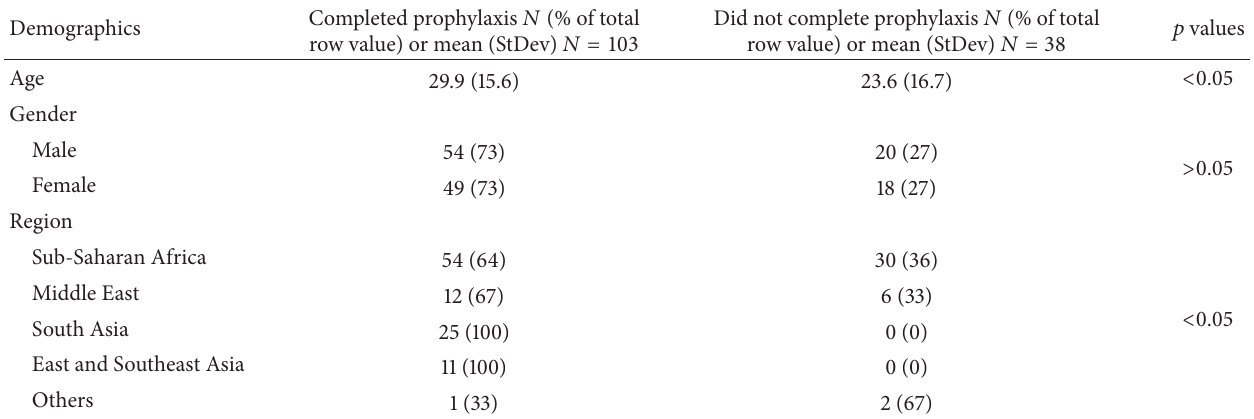
Table 2: Of those patients accepting treatment for latent tuberculosis infection, this is a comparison of completers versus noncompleters of tuberculosis prophylaxis by age, gender, and country of